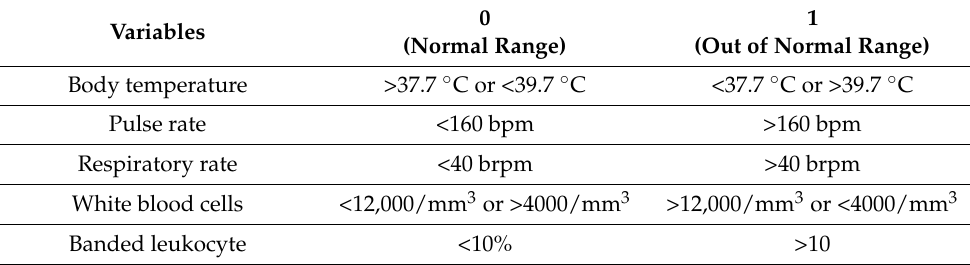
Table 1. A scoring system used for SIRS diagnosis in dogs enrolled. 0 1 Variables (Normal Range) (Out of Normal Range) Body temperature >37.7 ◦ C or <39.7 ◦ C <37.7 ◦ C or >39.7 ◦ C Pulse rate <160 bpm >160 bpm Respiratory rate <40 brpm >40 brpm White blood cells <12,000/mm 3 or >4000/mm 3 >12,000/mm 3 or <4000/mm 3 Banded leukocyte <10%